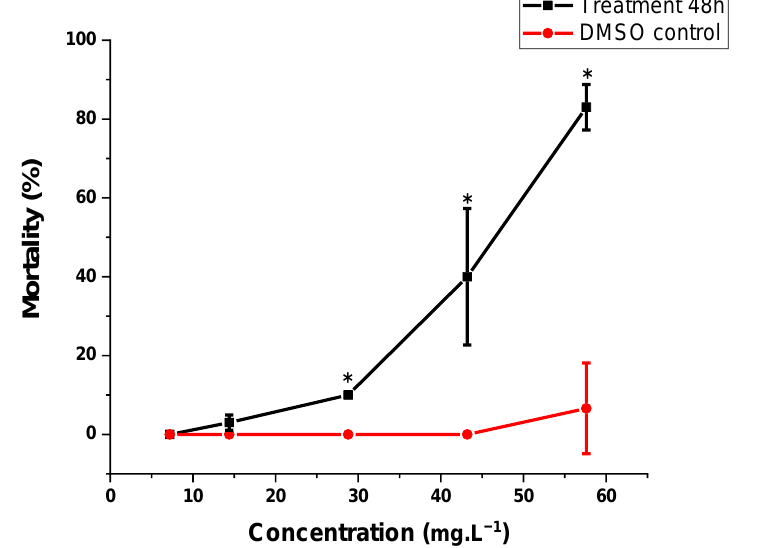
Figure 16. Ae. aegypti larvae mortality (%) as a function of BBP concentration (mg · L − 1 ). The symbol (*) indicates statistical significance with the DMSO group (ANOVA/Tukey; p ≤ 0.05). A mortality rate depends on the concentration of BBP used was observed, presenting a rate up to 80% at 57.6 mg L − 1 , in 48 h (Figure 15). In comparison to the literature, the bromochalcone derivative (BBP) showed greater larvicidal activity than other bromochalcone derivatives evaluated by Kalirajan et al. (2015) on Culex sp. and Anopheles sp. [58]. Eight of these molecules showed LC50-24 h values greater than 50 mg · L − 1 . Table 4 presents the structure–activity relationship of bromochalcone derivatives concerning Ae. aegypti larvae mortality Table 4. Structure – activity relationship of bromochalcone derivatives concerning A. aegypti larvae mortality (%).